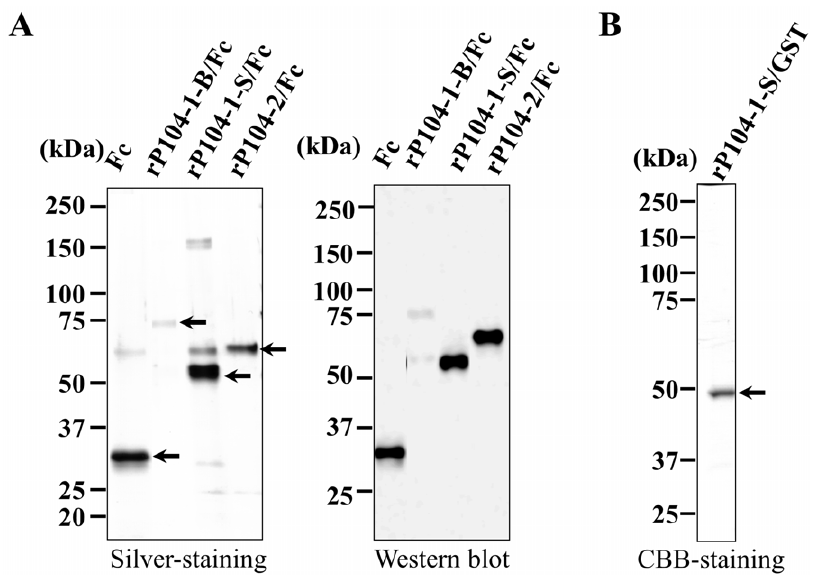
Figure 2. Recombinant proteins synthesized by eukaryotic and prokaryotic expression systems. A. Left panel, silver-stained gel showing the recombinant proteins with their expected molecular weights purified from the Tn5 (insect) cell culture medium. Right panel, purified recombinant proteins were transferred onto a PVDF membrane and anti-mouse Fc antibody was employed to detect the Fc-recombinant protein bands. B. CBB-stained gel showing the fusion protein rP104-1-S/GST purified from E. coli . The purified proteins are shown by arrows. The molecular masses in kDa are shown on the left.